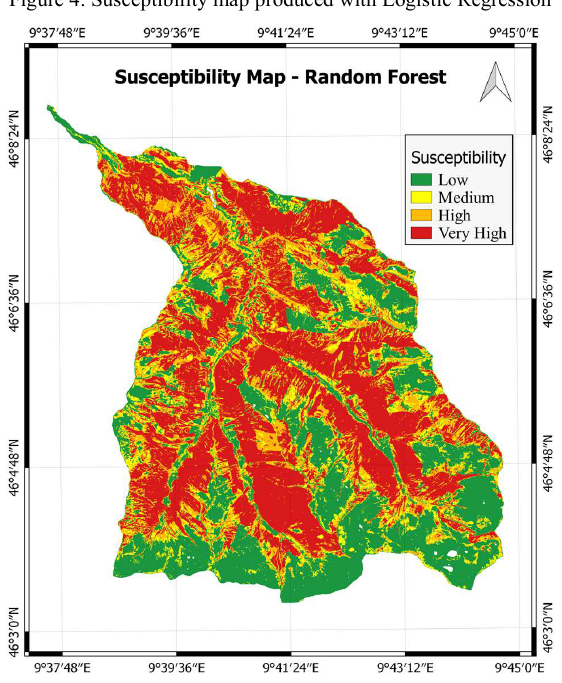
Figure 5. Susceptibility map produced with Random